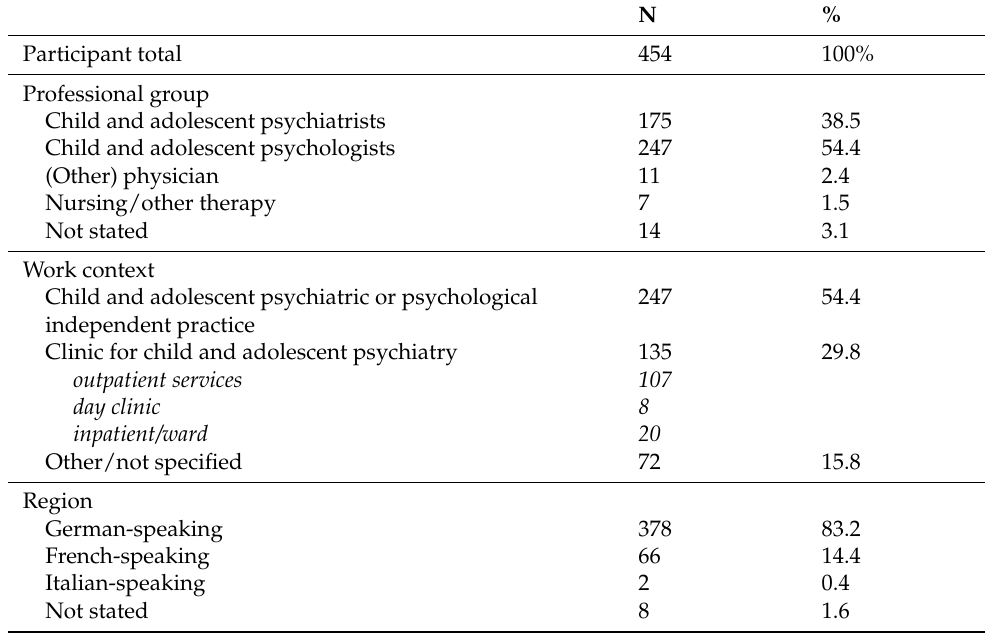
Table 1. Participants.